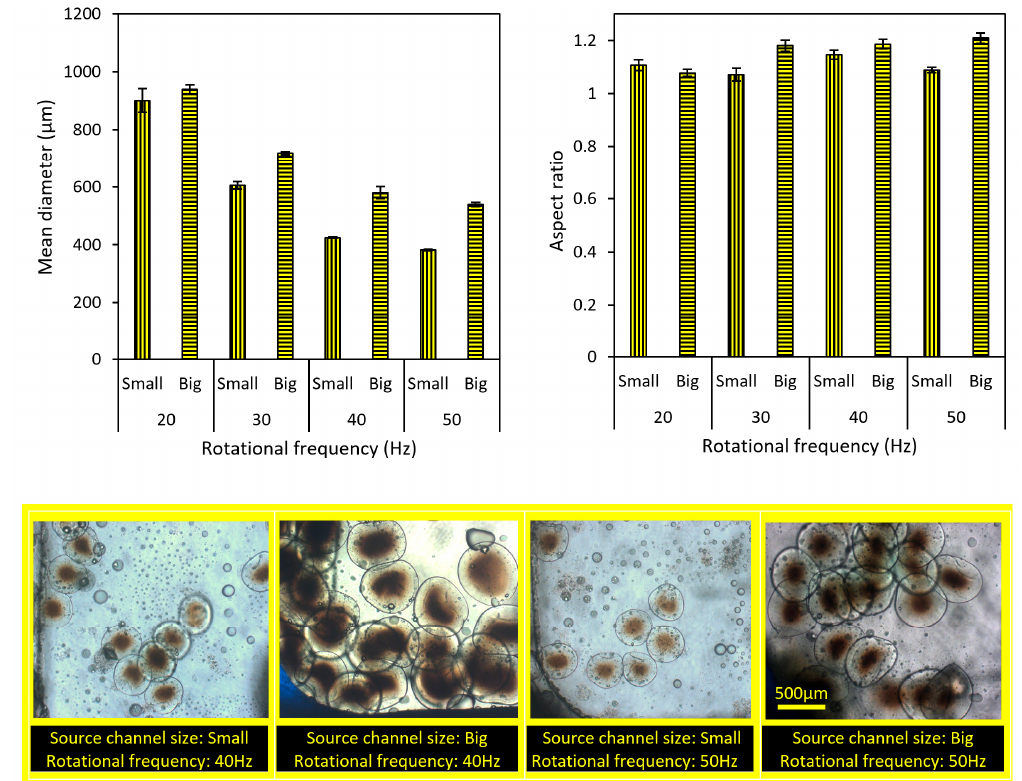
Figure 8. Microparticles’ size and aspect ratio (mean ± standard error) at different rotational fre- quencies. The fluidic barrier length is considered to be a constant (=2 cm). Scale bar is 500